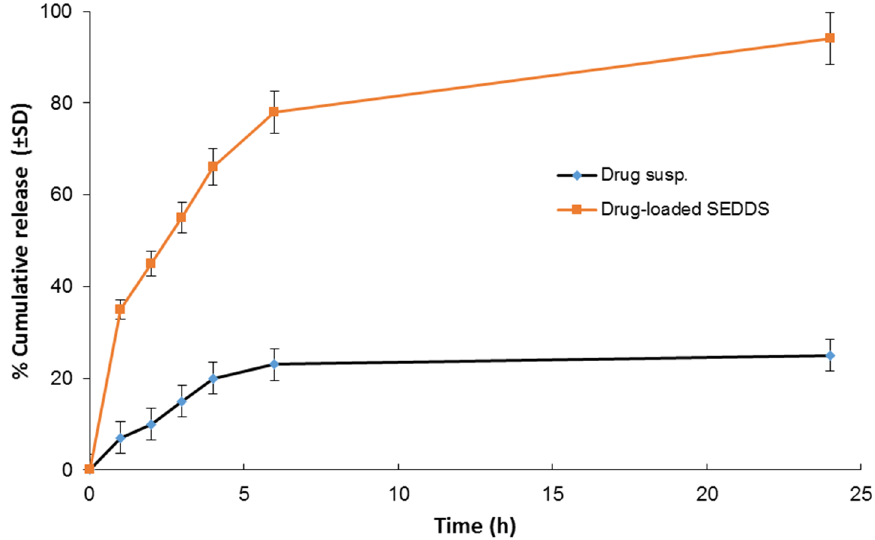
Figure 3. In vitro release study of the drug from the prepared SEDDS compared to the drug suspension.